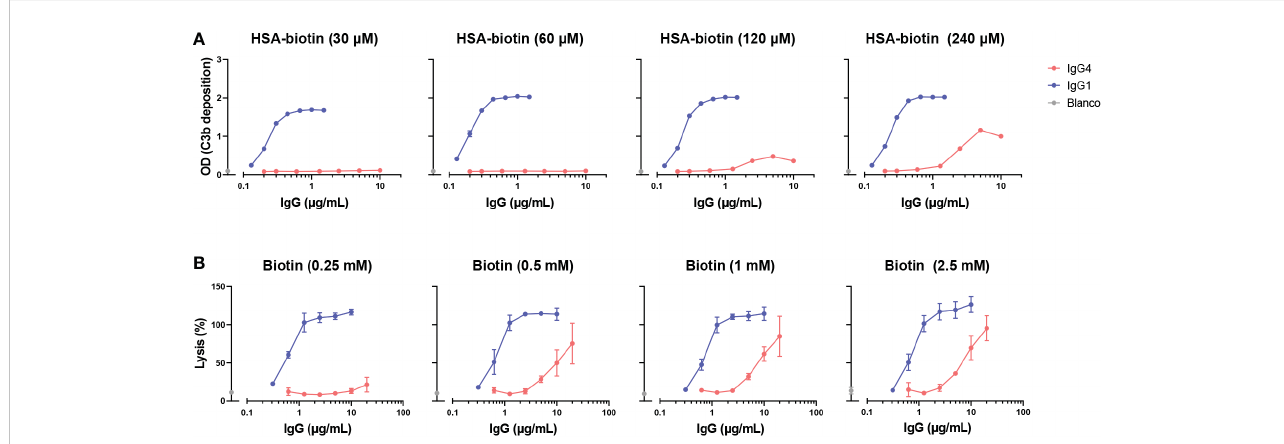
FIGURE 2 IgG4 activates complement at high antigen densities and antibody concentrations. (A) C3b deposition induced by anti-biotin IgG1 and IgG4 antibodies on biotinylated human serum albumin (HSA; 30, 60, 120 and 240 m M biotin; corresponding to approximately 2, 4, 8 and 50 biotins per HSA molecule respectively), in the presence of 2.5% human serum. All antibodies were tested in a two-fold serial dilution starting from 10 µg/mL for IgG4 and 2 µg/mL for IgG1 antibodies in four independent assays. (B) The capacity of biotin-speci fi c IgG1 and IgG4 antibodies to induce complement-mediated lysis (as percentage) of biotinylated human red blood cells at various antigen densities (0.25, 0.5, 1, and 2.5 mM biotin) in the presence of 10% human serum. All antibodies were tested in a two-fold serial dilution starting from 20 µg/mL for IgG4 and 10 µg/mL for IgG1 antibodies in triplicates. The data was normalized to a 100% lysis control (RBCs with